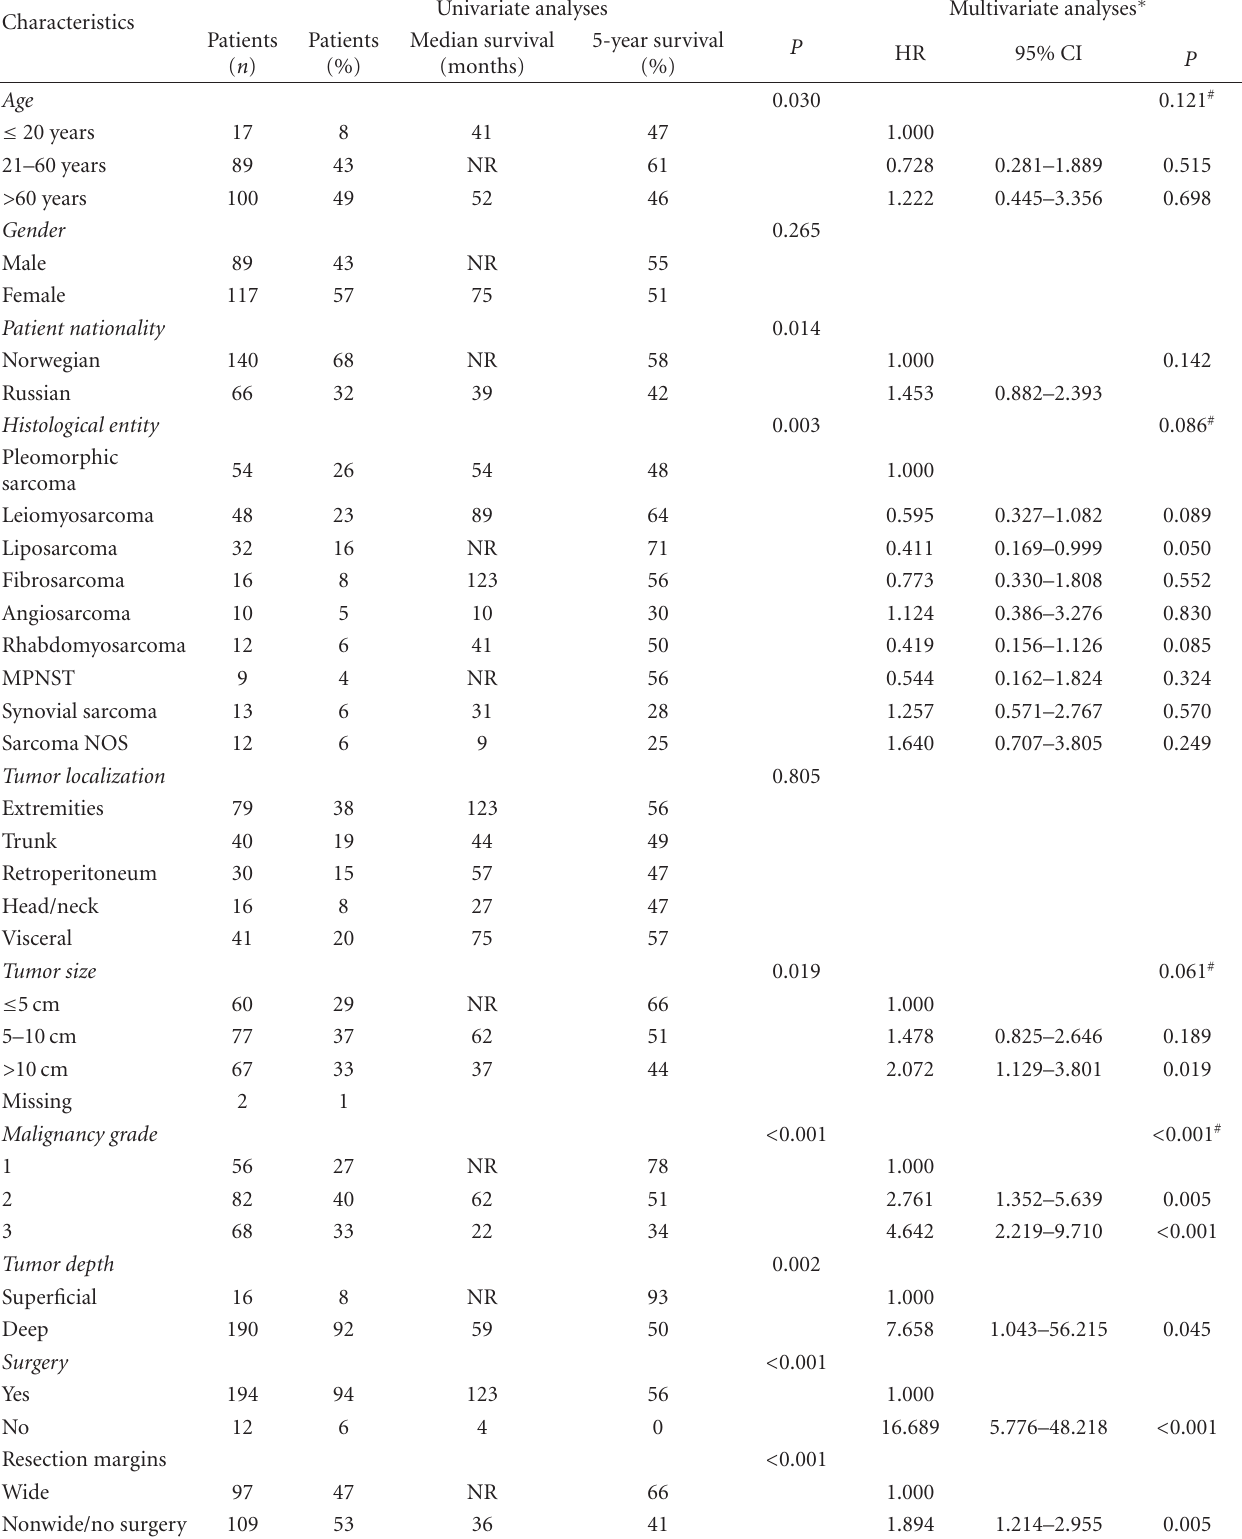
Table 1: Prognostic relevance of clinicopathological variables for disease-specific survival in 206 non-gastrointestinal stromal tumor soft- tissue sarcomas (univariate analyses, log rank test, multivariate analyses, Cox proportional hazards